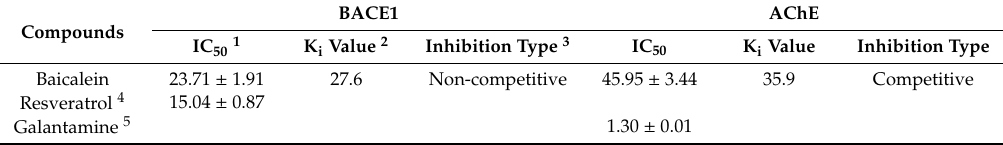
Figure 1. The chemical structure of baicalein. Table 1. BACE1 and AChE inhibitory activities and kinetic analysis of baicalein.